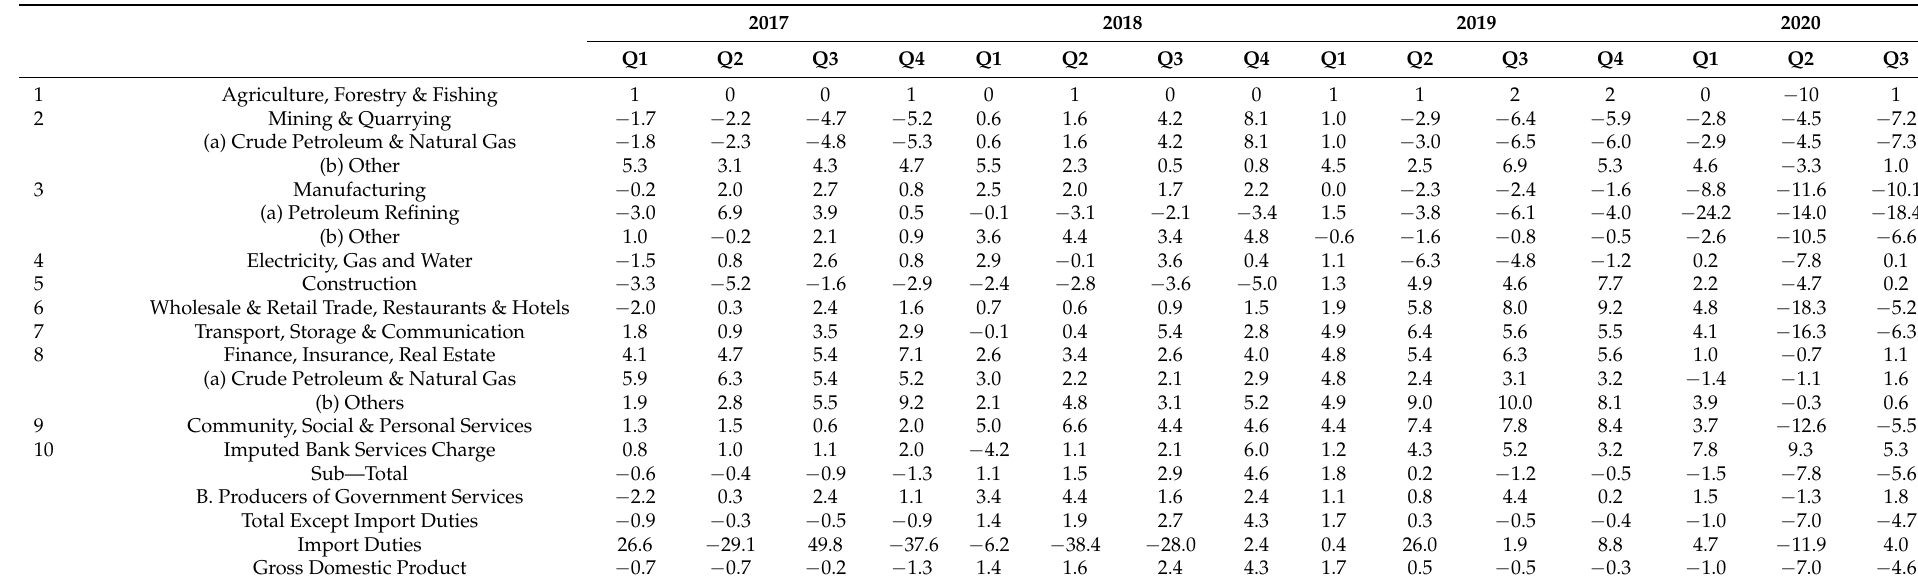
Table 1. Annual growth rates of gross domestic product by kind of economic activity at constant prices (2010 = 100). Source GASTAT